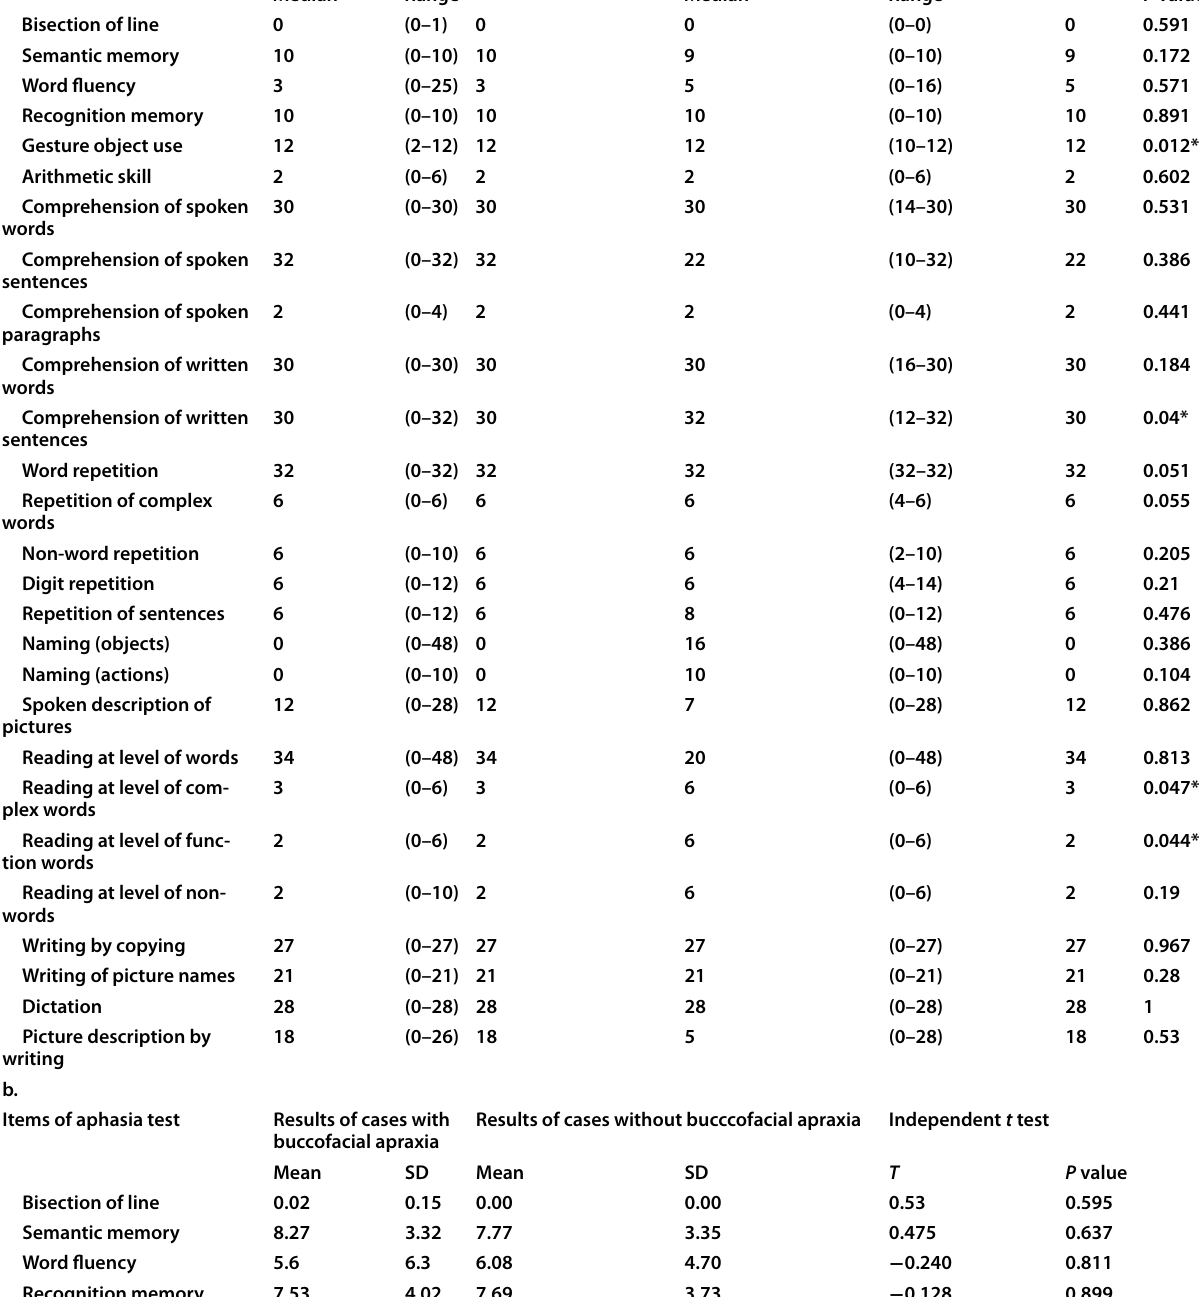
Table 5 Comparison between patients with buccofacial apraxia and without buccofacial apraxia regarding scores of aphasia test. Table 5 (a) that was statistically analyzed using the median shows that there was a significant difference between patients with buccofacial apraxia and patients without buccofacial apraxia in the scores of aphasia test in gesture object use, written sentences comprehension, reading complex, and function words. Table 5 (b) that was statistically analyzed using the mean reveals that there was a significant difference between patients with buccofacial apraxia and patients without buccofacial apraxia in the scores of aphasia test in complex word repetition, reading complex words, andreading